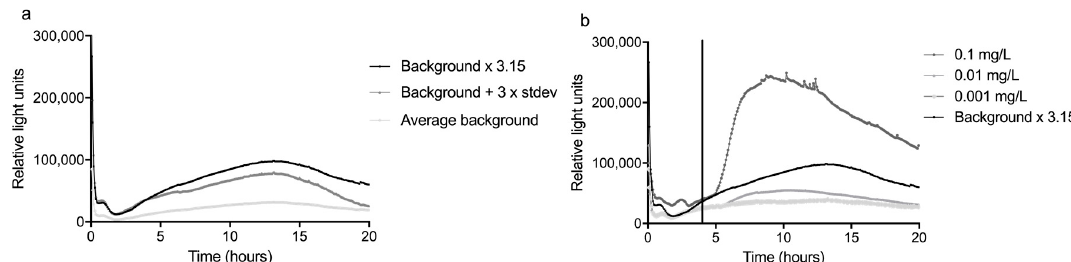
Figure 6. Determination of the background and response of the sensor at monitoring station Keizersveer. ( a ) shows the average of five background experiments, the average background + 3 times the standard deviation and the average background x the response ratio of 3.15. In ( b ), the response to three concentrations of mitomycin C, added between 4 and 5 h, are compared to the background x 3.15.